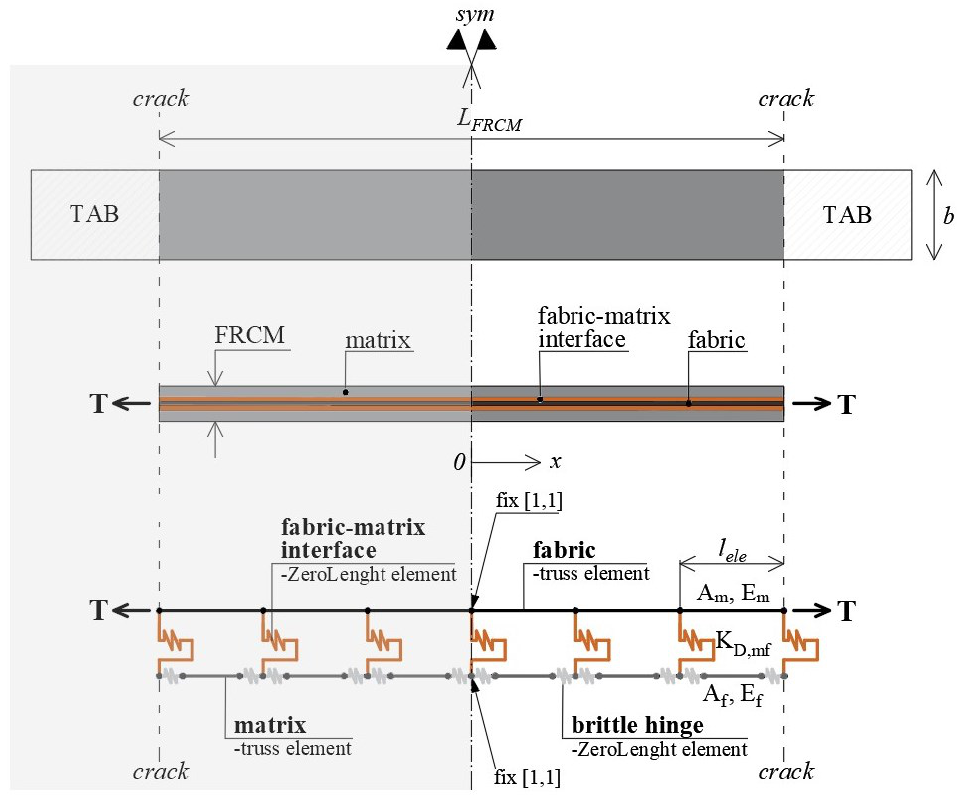
Figure 1. 1D numerical models for tensile behavior.